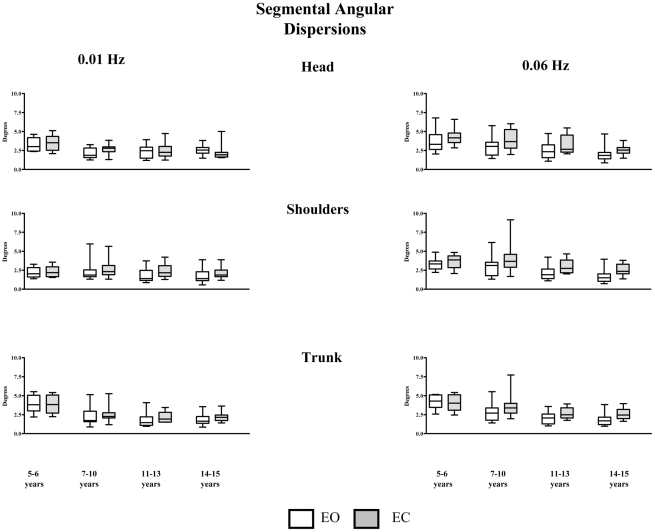
Box and whisker -median and interquartiles range maximum and minimum- of roll head, shoulders, trunk and pelvis (top to down) angular dispersion (degrees), with eyes open (white) and eyes closed (grey) in subjects from 5 to 15 years at 0.01 Hz (left panel) and at 0.06 Hz (right panel).